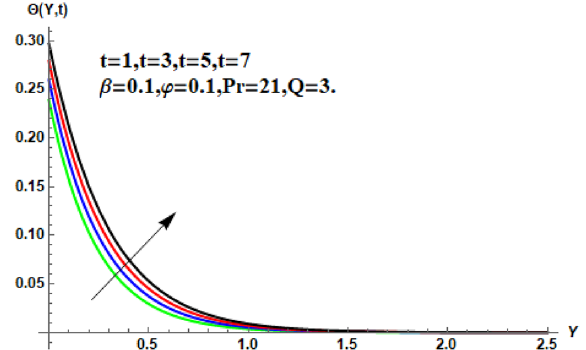
Figure 5. Temperature profile for different values of t .